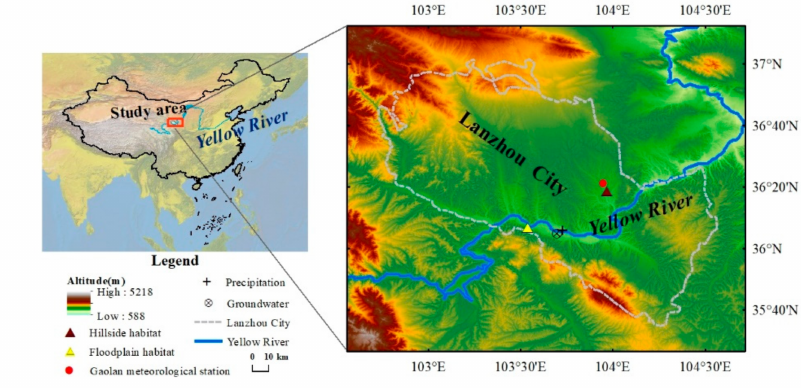
Figure 1. Location of the study area and sampling sites, including the hillside and floodplain habitats in the Lanzhou